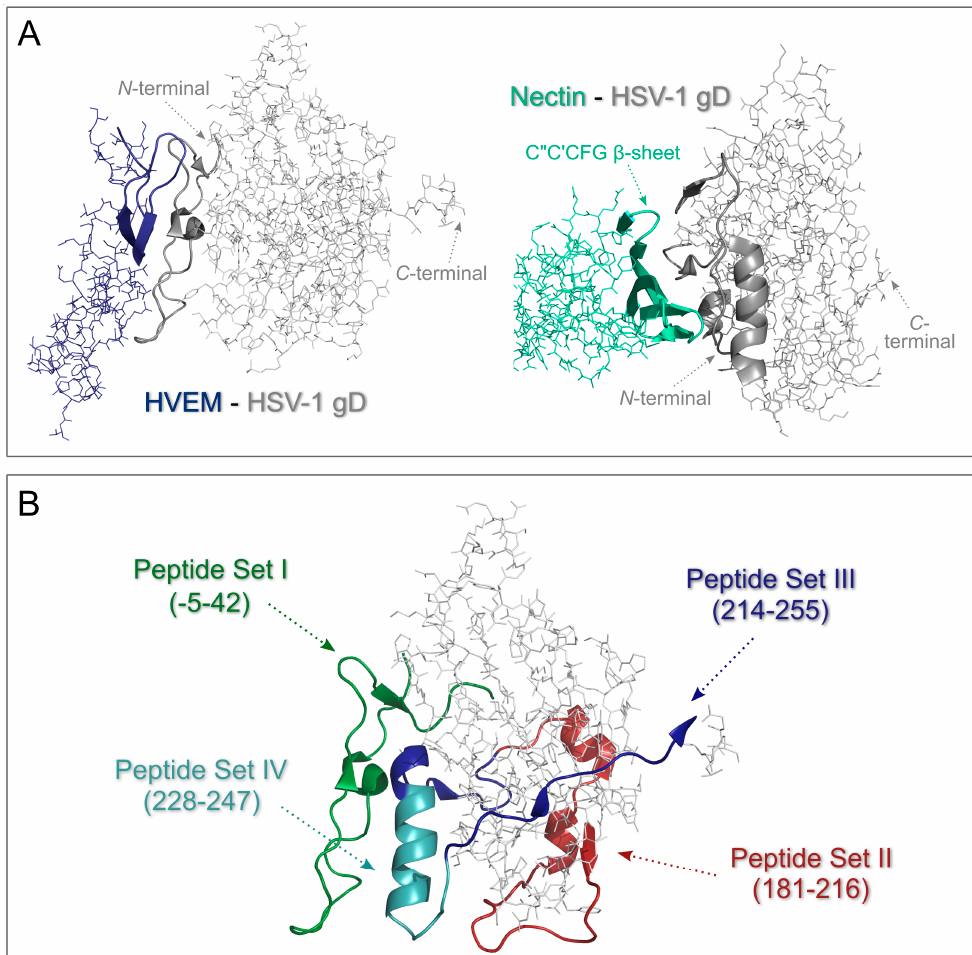
Figure 1. ( a ) Structure of HVEM – HSV-1 gD complex (1JMA) and the first domain of nectin-1 in complex with HSV-1 gD (3U82) with the binding interface shown in ribbon model. Similar orientation of the HSV-1 gD protein has been intended, but the conformation of the protein is not identical in the different complexes. ( b ) Localisation of the regions defining the four peptide sets (I-IV) designed for synthesis based on the sequence of HSV-1 gD glycoprotein (PDB ID: 1JMA).